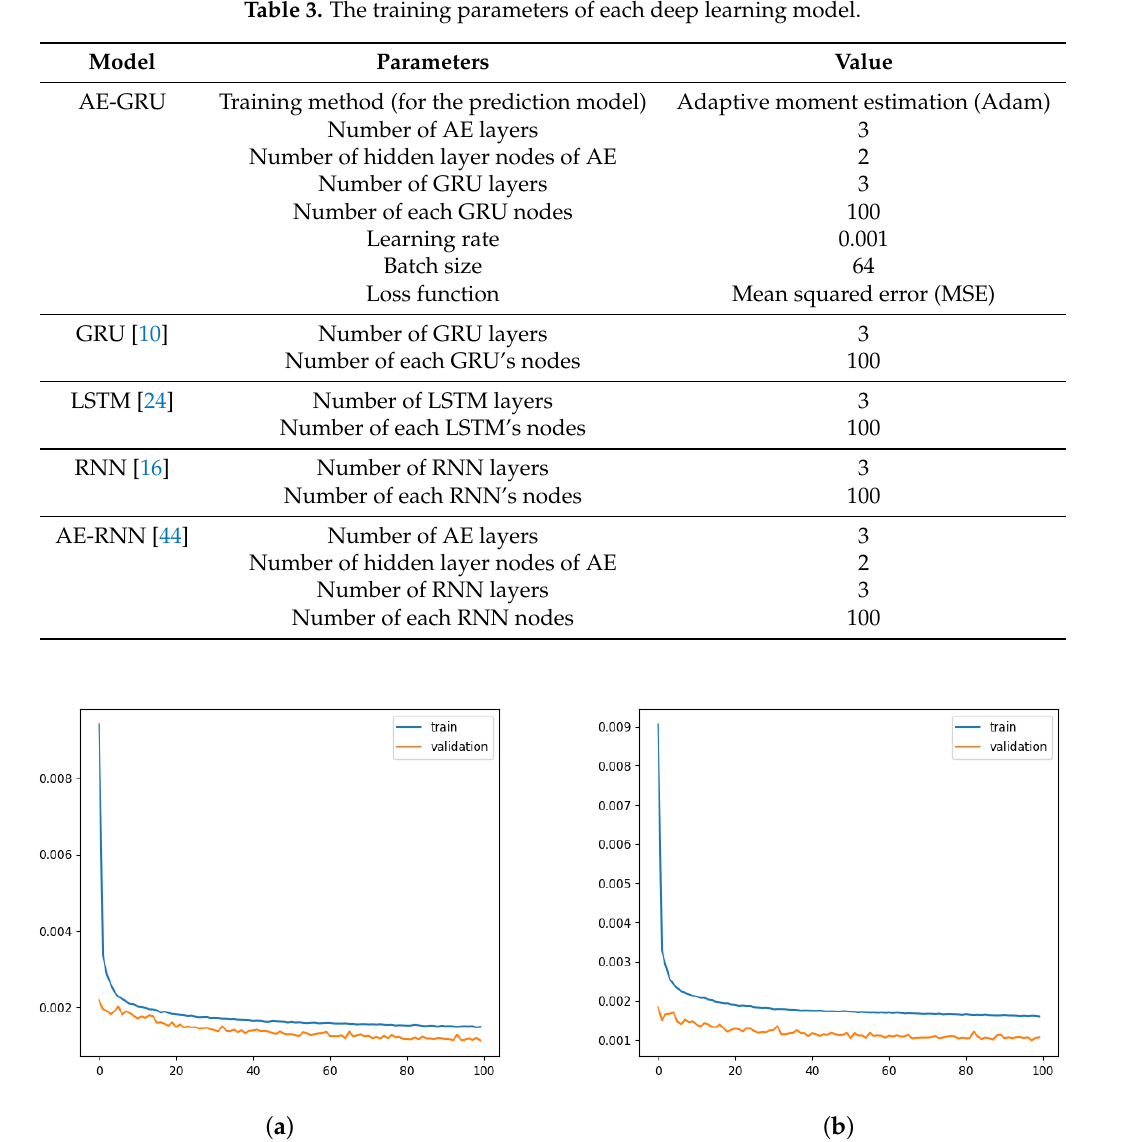
Figure 5. The loss of AE-GRU. ( a ) The train/validation loss of latitude. ( b ) The train/validation loss of